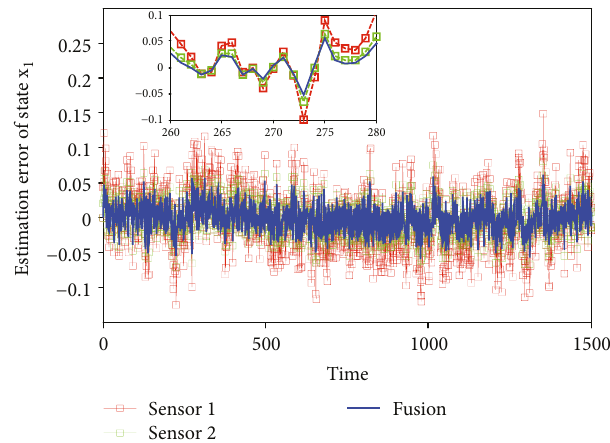
Figure 12: The estimate error of x ( L =50).